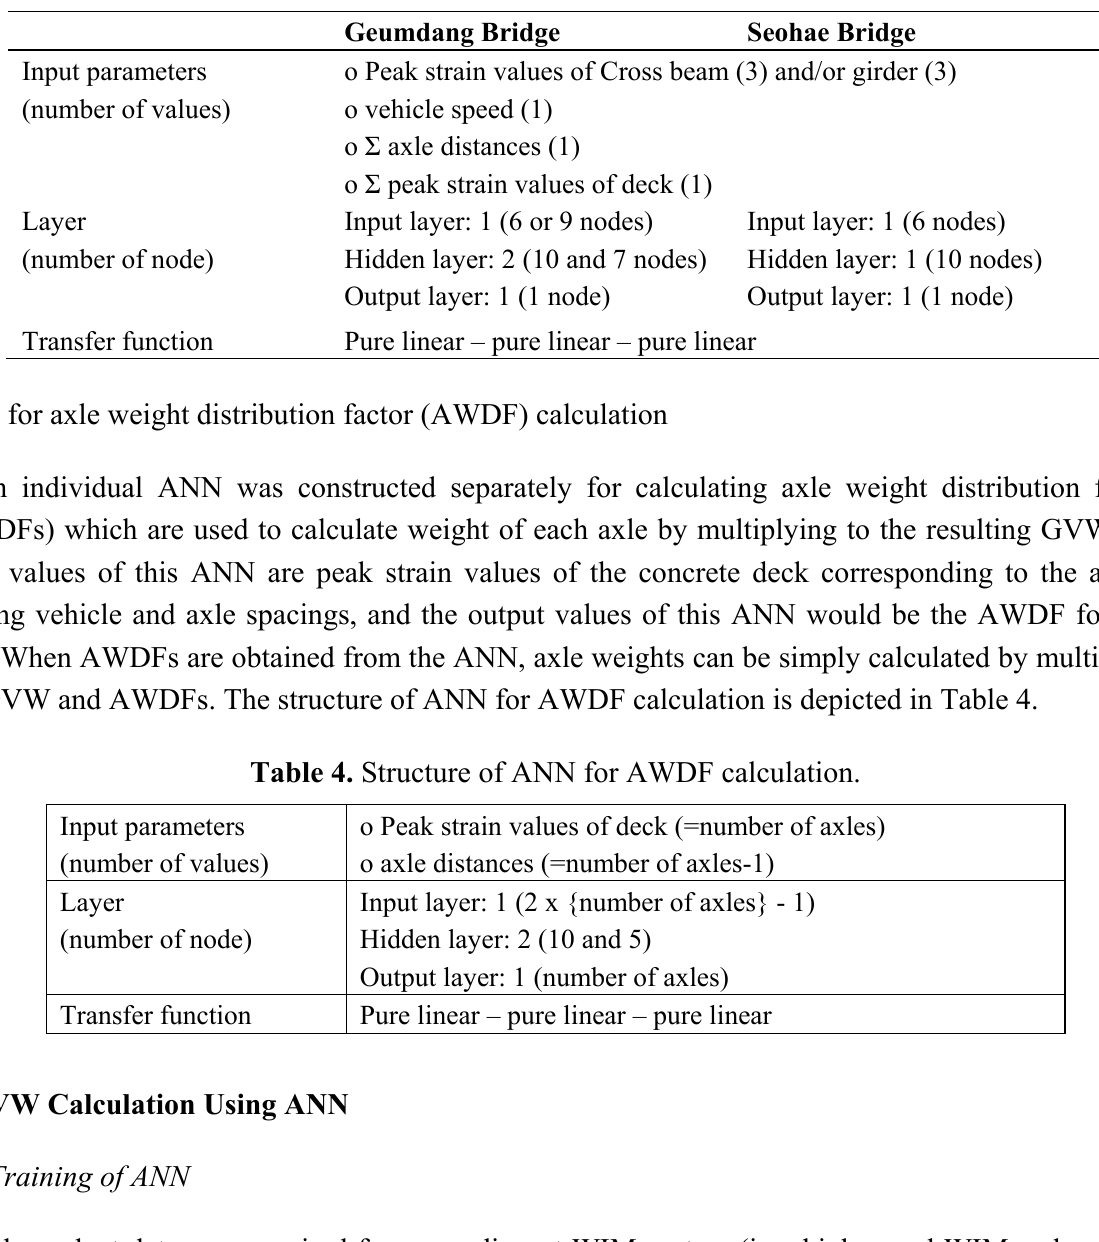
Table 3. Structures of ANN for GVW calculation.